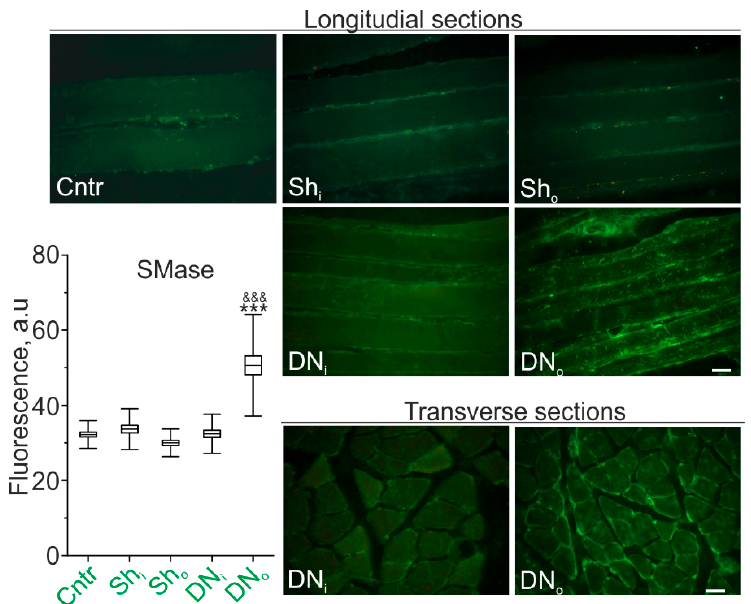
Figure 1. SMase is upregulated in denervated rat soleus muscle. Expression of immunoreactive SMase in sections of soleus muscle fibers of the control (Cntr), unilaterally sham-operated (Sh) and unilaterally denervated (DN) rats. Sh i and Sh o —muscles from the intact and sham-operated limb; DN i and DN o —muscles from the intact and denervated limb. Shown longitudinal (Cntr, Sh, DN) and transverse (DN) sections. Scale bars—10 μ m. Left: quantification of fluorescence (mean; box range—SEM; whiskers—SD); N = 6 animals for each group. *** p < 0.001—in comparison to the intact limb; &&& p < 0.001 in comparison to the sham-operated control. p was evaluated by a two-way ANOVA followed by Bonferroni post hoc test.